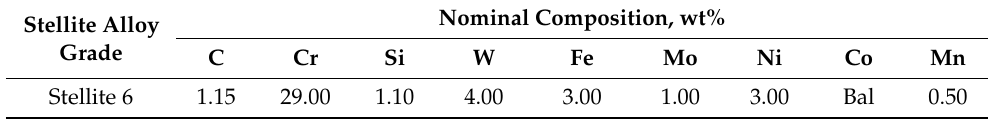
Table 2. Chemical composition (wt%) of Stellite 6 cladding material.